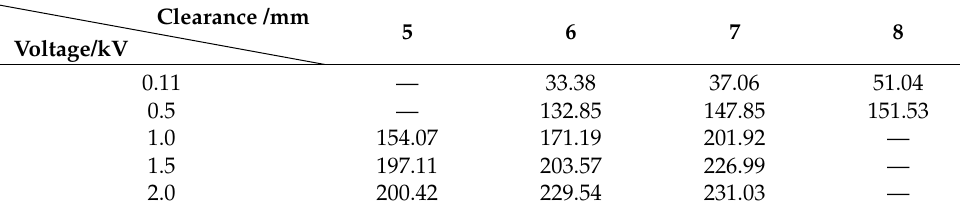
Table 7. Height of local deformation of the tube (µm) for different initial gaps and discharge volt- ages.